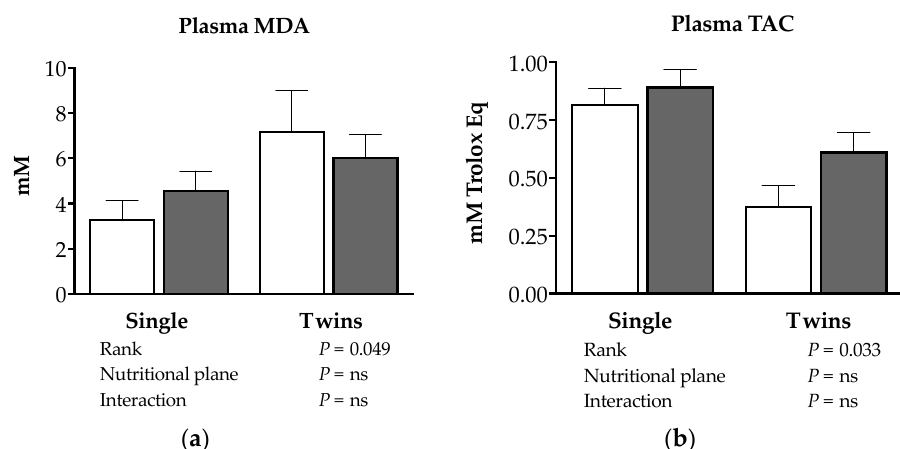
Figure 3. ( a ) Plasma MDA. ( b ) Plasma TAC. Antioxidant status of venous cord blood plasma at 140 days of gestation in ewes bearing single and twin fetuses, maintained under adequate or deprived nutritional planes. The mpty bars correspond to unsupplemented animals. The gray bars correspond to animals fed with natural pasture plus concentrate supplementation. The corresponding effects and their statistical significance are presented as footnote in each figure. MDA: malondialdehyde; TAC: total antioxidant capacity.